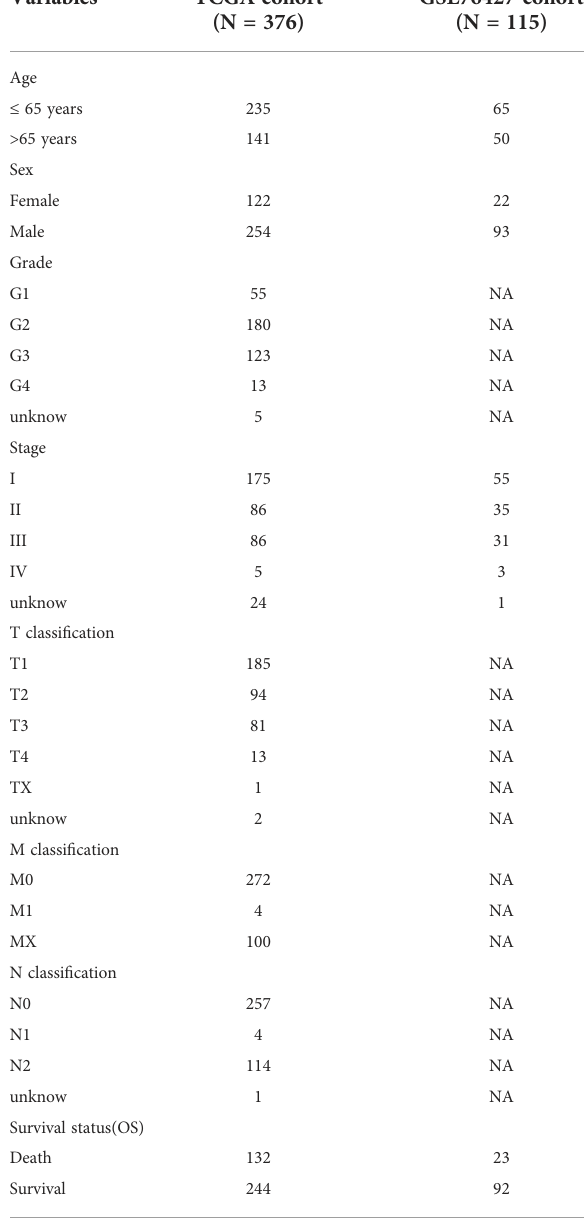
TABLE 1 The clinical characteristics of the TCGA cohort and GSE76427